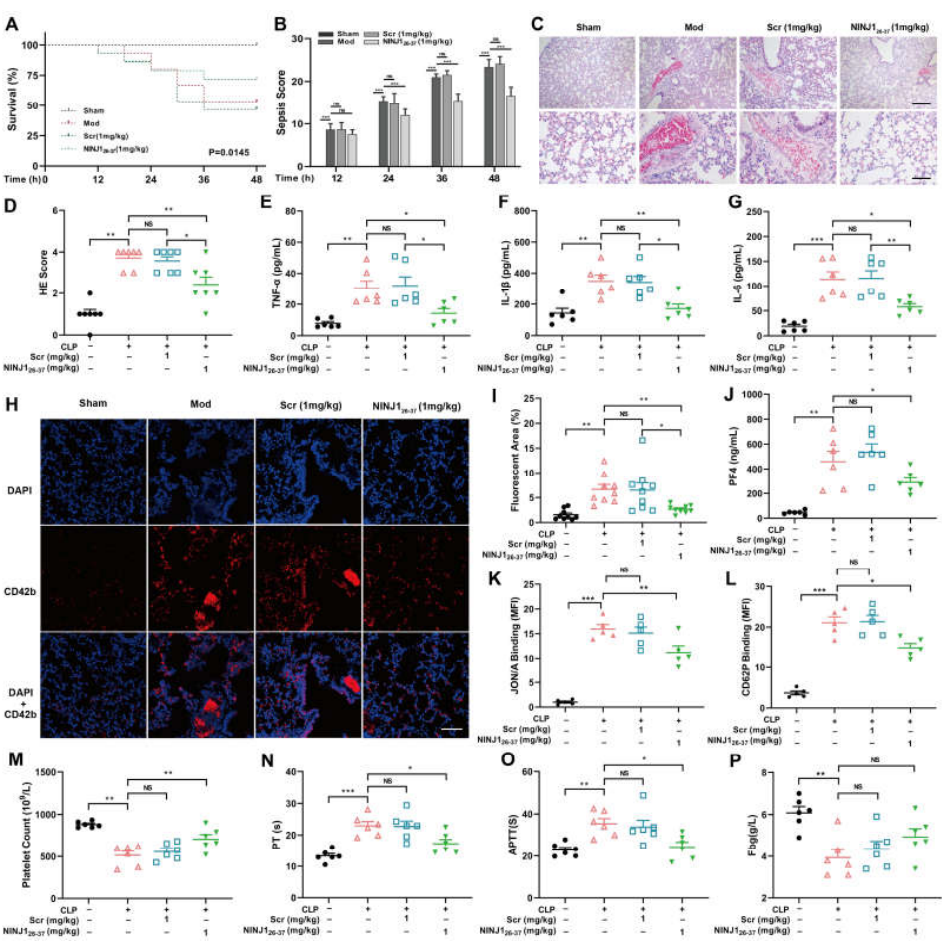
Figure 6. Inhibition of NINJ1 attenuates platelet activation and inflammatory reaction in sepsis. ( A ) In the CLP-induced sepsis murine model, mice with sepsis were evaluated with MSS scores at different times (12, 24, 36, or 48 h). Values are mean ± SEM, n = 15. * p < 0.05, ** p < 0.01, *** p < 0.001. Two-way ANOVA with Tukey’s multiple comparison test. ( B ) A 48-h log-rank (Mantel–Cox) test in the CLP-induced sepsis murine model was performed ( n = 15). ( C ) Lung tissues of mice with CLP-induced sepsis were collected for HE staining and ( D ) lung injury score. Values are mean ± SEM, n = 7. Scatter diagrams showing plasma levels of TNF-α ( E ), IL-1β ( F ) and IL-6 ( G ) in the CLP-induced sepsis murine model. Values are mean ± SEM, n = 6. ( H ) Lung tissues of mice with CLP-induced sepsis were collected, and, once fixed and stained with CD42b and DAPI, were observed with a fluorescence microscope. Scale bar represents 50 µ m. ( I ) Fluorescent area of CD42b from nine randomly selected fields of three different tests. ( J ) Scatter diagrams showing plasma levels of PF4 in the CLP-induced sepsis murine model. Values are mean ± SEM, n = 6. ( K ) Effect of inhibition of NINJ1 on integrin α IIb β 3 activation and ( L ) P-selectin exposure in CLP-induced sepsis murine model platelets, n = 5. Blood was collected from mice for measuring the ( M ) platelet count, ( N ) PT, ( O ) APTT and ( P ) Pbg, n = 6. NS = p > 0.05, * p < 0.05, ** p < 0.01, *** p < 0.001. One-way ANOVA with Tukey’s multiple